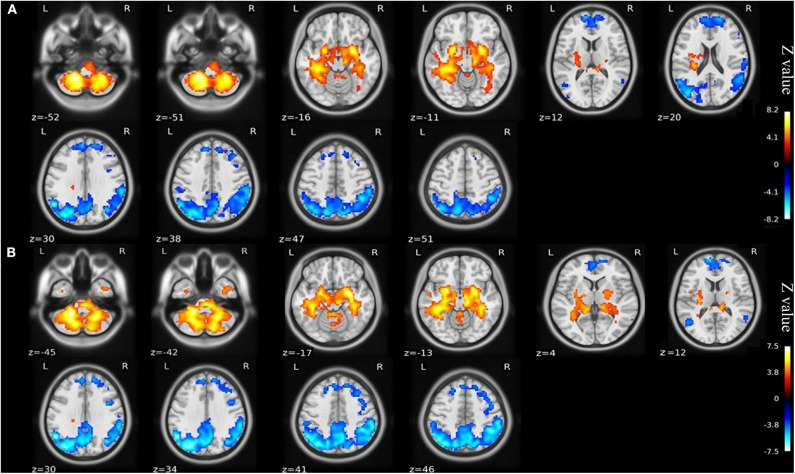
(A) ALFF maps show differences between KOA older patients (n = 23) and healthy matched controls (n = 23). (B) ALFF maps show differences between postoperative patients (n = 15) and healthy matched controls (n = 23) (voxel-wise p < 0.001 and cluster-wise p < 0.025 for each tail, corrected by GRF). Diffused ALFF decreases in the bilateral angular, precuneus, and medial superior frontal gyrus and increases in the bilateral amygdaloid nucleus and cerebellum posterior lobe (left Cerebelum_9 and right Cerebelum_8) are observed consistently in the KOA older patients and postoperative patients compared to controls. The symmetric color bars range from -vmax to vmax, which denotes the absolute value of the extreme z-value. ALFF, amplitude of low frequency fluctuation; KOA, knee osteoarthritis.